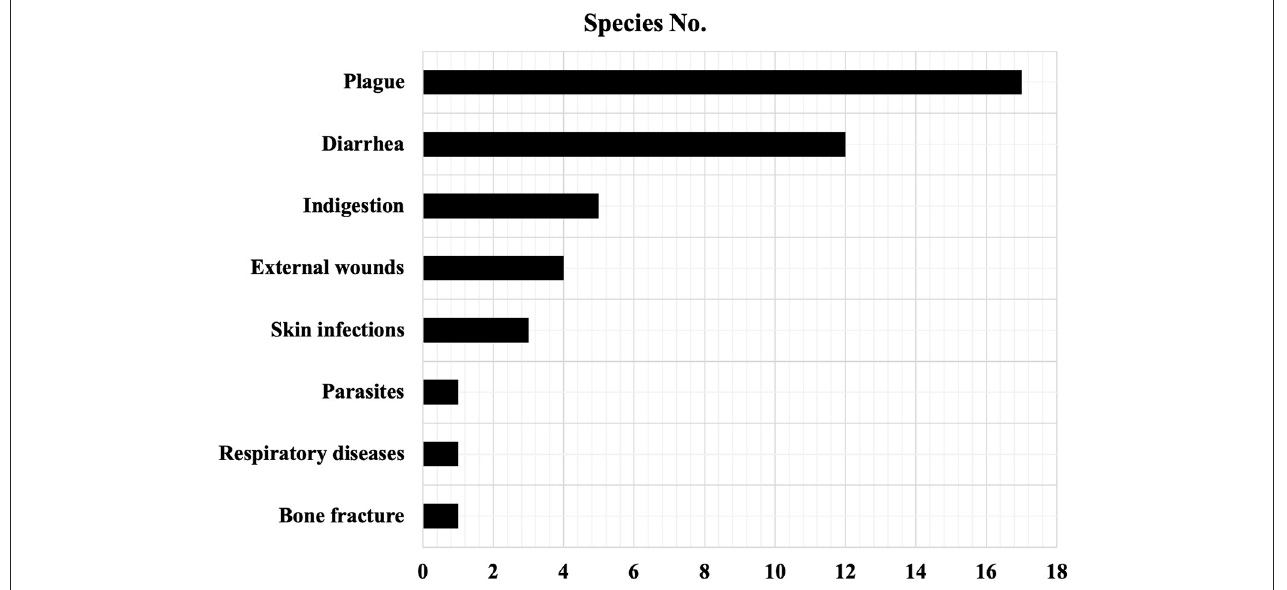
FIGURE 2 | Disease types targeted by ethnoveterinary medicines in the Baiku Yao